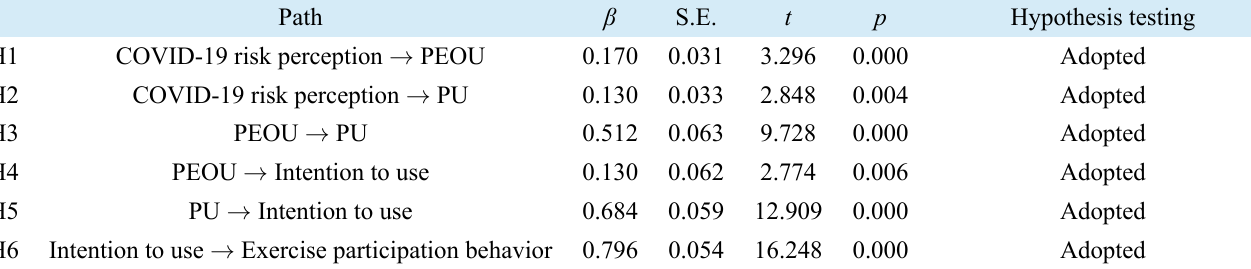
TABLE 4. Structural equation